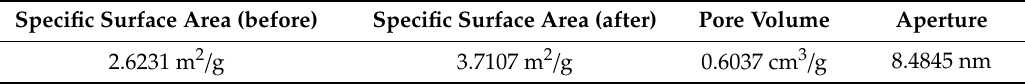
Table 6. NICLS property parameters.